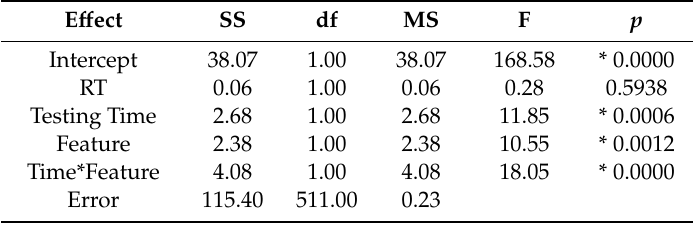
Table 12. Results of a linear model for the dependent variable—Accuracy for L3 German. E ff